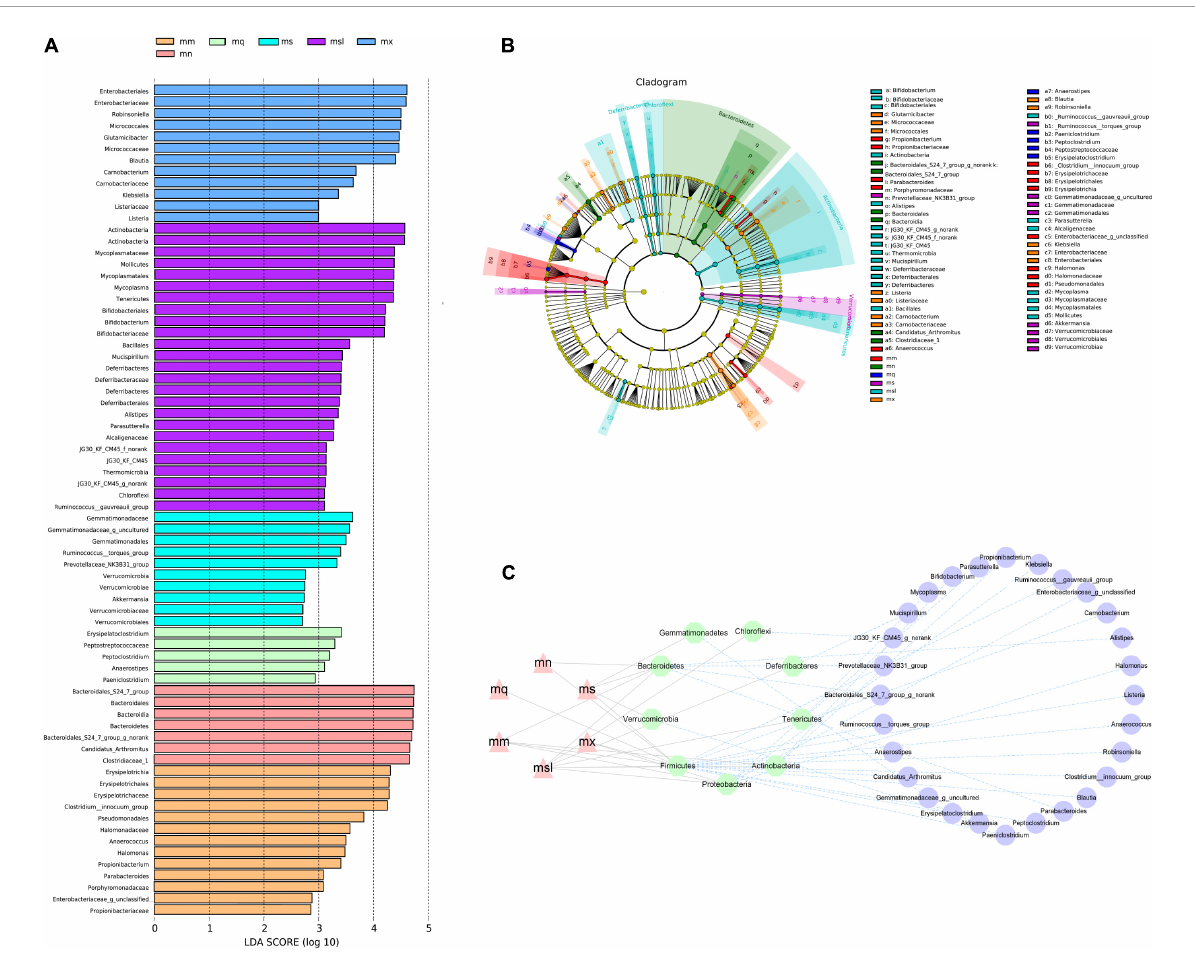
FIGURE5 Differential bacterial taxa between different sweeteners. (A) Cladogram diagram. (B) LDA scores Chart. (C) Interaction network of “group—phylum—genus”. mn, Control group; mm, Model group; mq, QWBZP group; ms, QWBZP + Sucrose group; mc, QWBZP + Saccharinn group; mx, QWBZP + Xylitol group; msl, QWBZP + Sorbitol